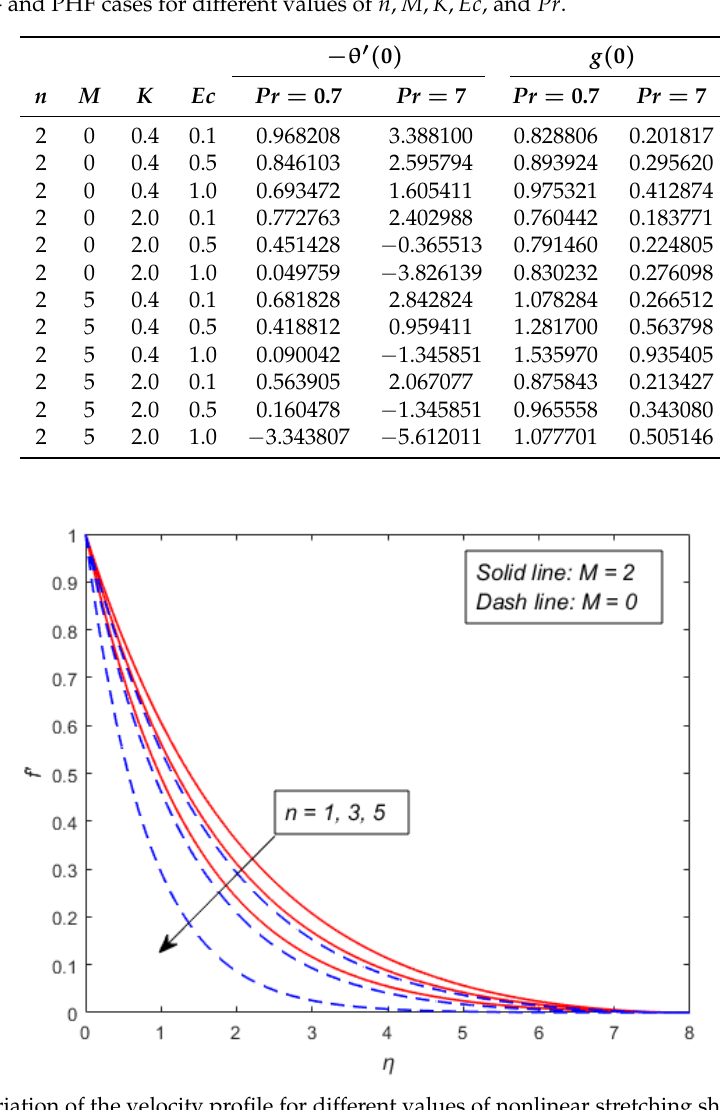
Figure 2. Variation of the velocity profile for different values of nonlinear stretching sheet parameter n and magnetic parameter M for K = 1, Pr = 0.71, and Ec =